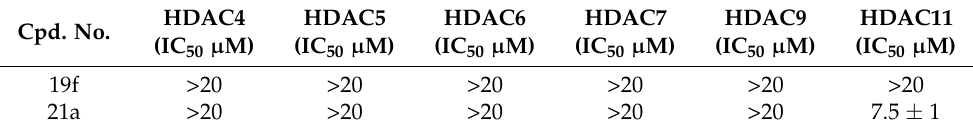
Table 2. Inhibitory activity of compounds 19f and 21a against class II and class IV HDACs. Cpd.